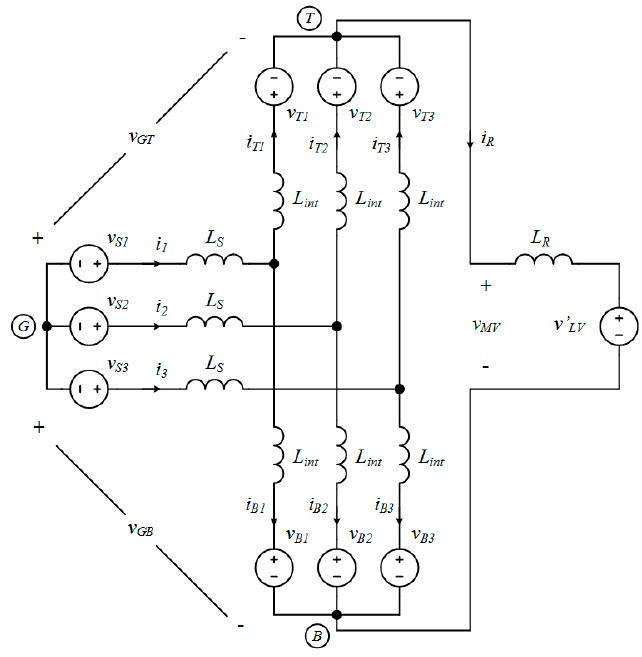
Figure 2. Equivalent circuit of the Modular Multilevel Converter (MMC)-based PET.